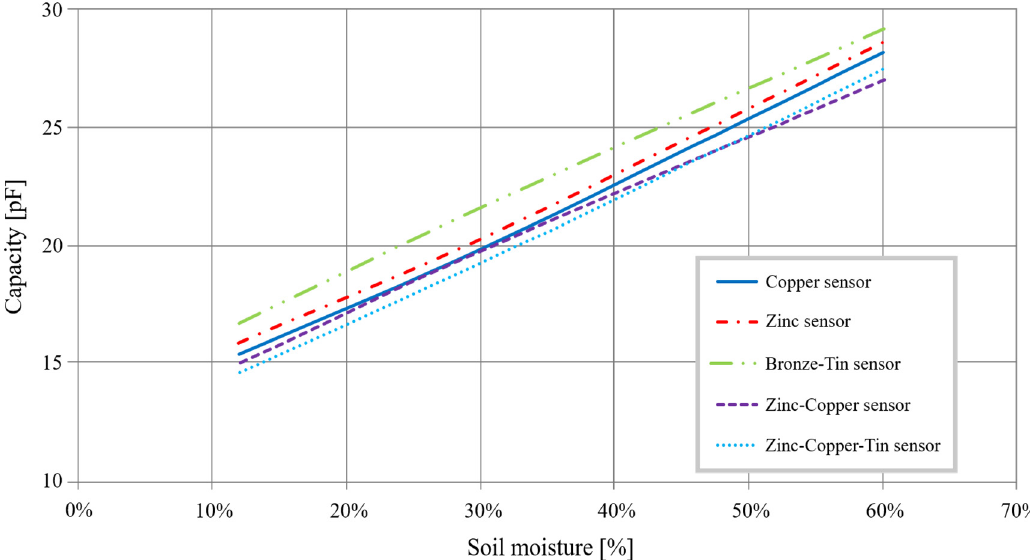
Figure 9. Di ff erent materials capacitance as a function of Figure 9. Different materials capacitance as a function of moisture.